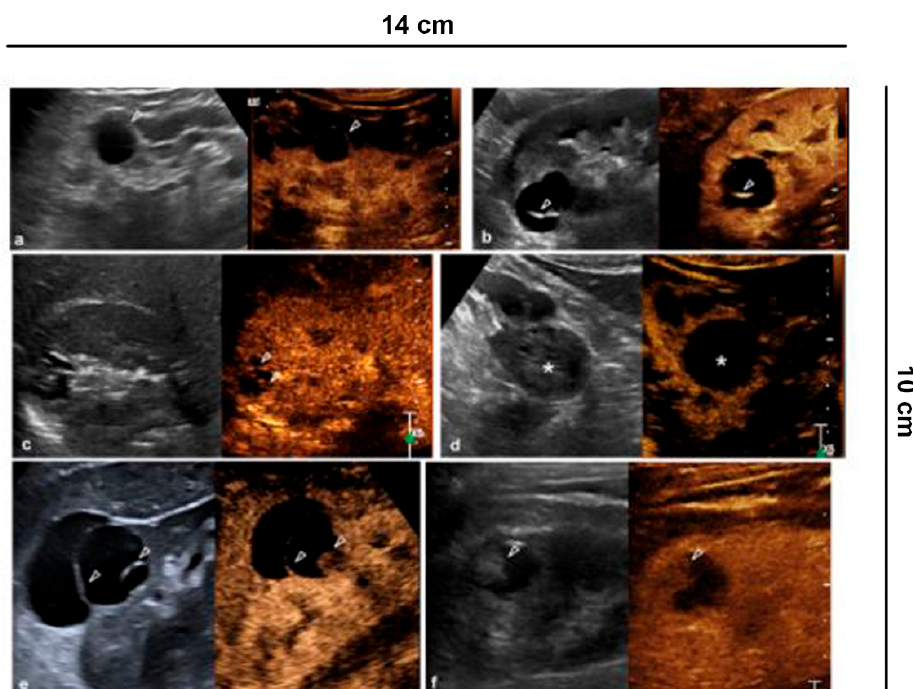
Figure 2. Characterization of cystic lesions. ( a ) Bosniak category I cyst (Simple benign cysts): B-mode US and CEUS show anechoic lesion without septa, calcification and wall irregularity; ( b ) Bosniak category II cyst (Minimally complex benign cysts): minimally complicated cyst with single calcific septum (arrowhead) on B-mode without recognizing enhancement on CEUS; ( c ) Bosniak category IIF cyst (Presumably benign, imaging surveillance is advised): on US B-mode, cyst with multiple thin septa, minimally thickened (2–3 mm), which on CEUS present minimal enhancement (arrowheads), without irregularities of both the wall and the septa; ( d ) Bosniak category IIF cyst (Presumably benign, imaging surveillance is advised): echogenic lesion with heterogeneous content inside (asterisk) on B ‐ mode US, which does not show wall enhancement or septa on CEUS; ( e ) Bosniak category III cyst (Indeterminate lesions): on B ‐ mode, cyst with two septa about 3 mm thick which have thickened, and irregular septa (arrowhead) on CEUS; ( f ) Bosniak category IV cyst (Likely malignant cystic tumors): cystic lesion with a wall nodule greater than 4 mm (arrowhead).